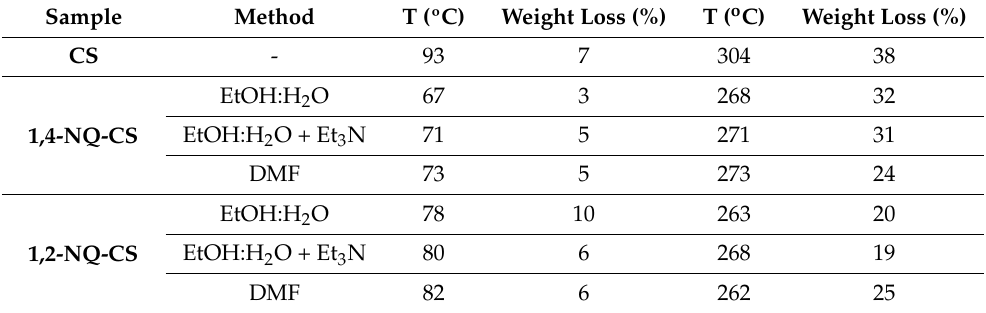
Table 2. Thermal properties of pure chitosan, 1,4-NQ-CS and 1,2-NQ-CS obtained by the